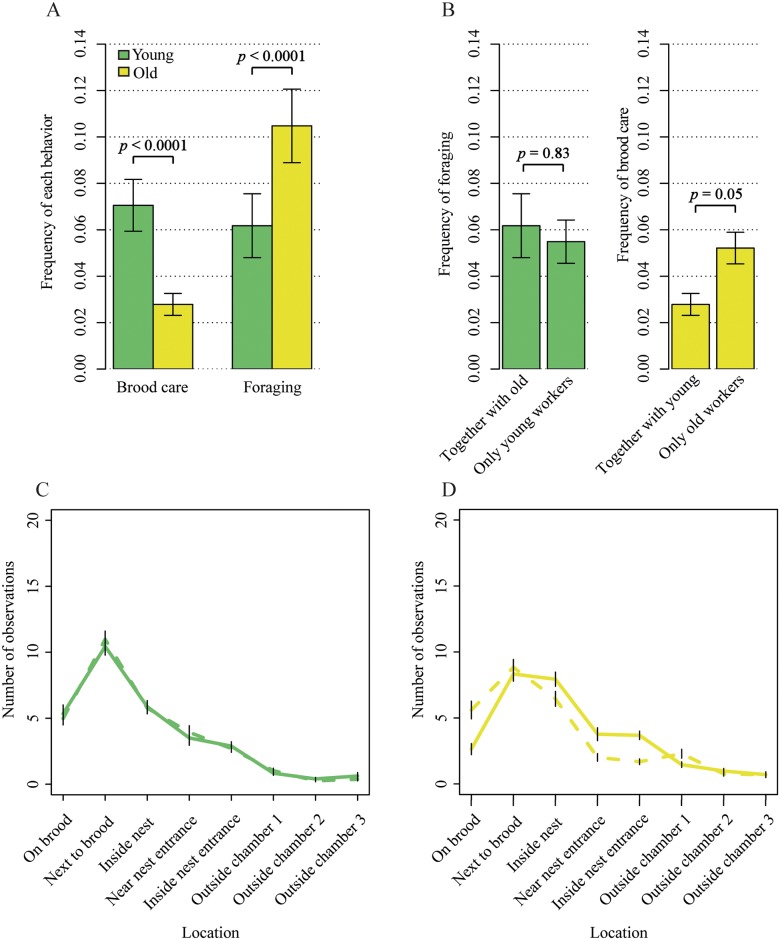
(A) In colonies with both age cohorts present (control), young workers preferably tended the brood, whereas old workers foraged. (B) Behavioral flexibility is age dependent. Young workers did not increase the frequency of foraging after old worker removal (left), whereas old workers increased brood-caring behavior following young worker removal. (C) Mean position of young workers did not depend on being together with old workers (solid line) or without old workers (dashed line). Vertical lines show standard error. (D) Old workers shifted their location towards brood pile in response to young worker removal (dashed line). Solid line shows positions of old workers when together with young workers.